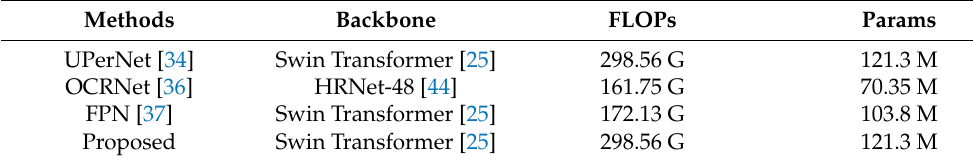
Table 6. Parameter size and floating point operations (FLOPs) for different